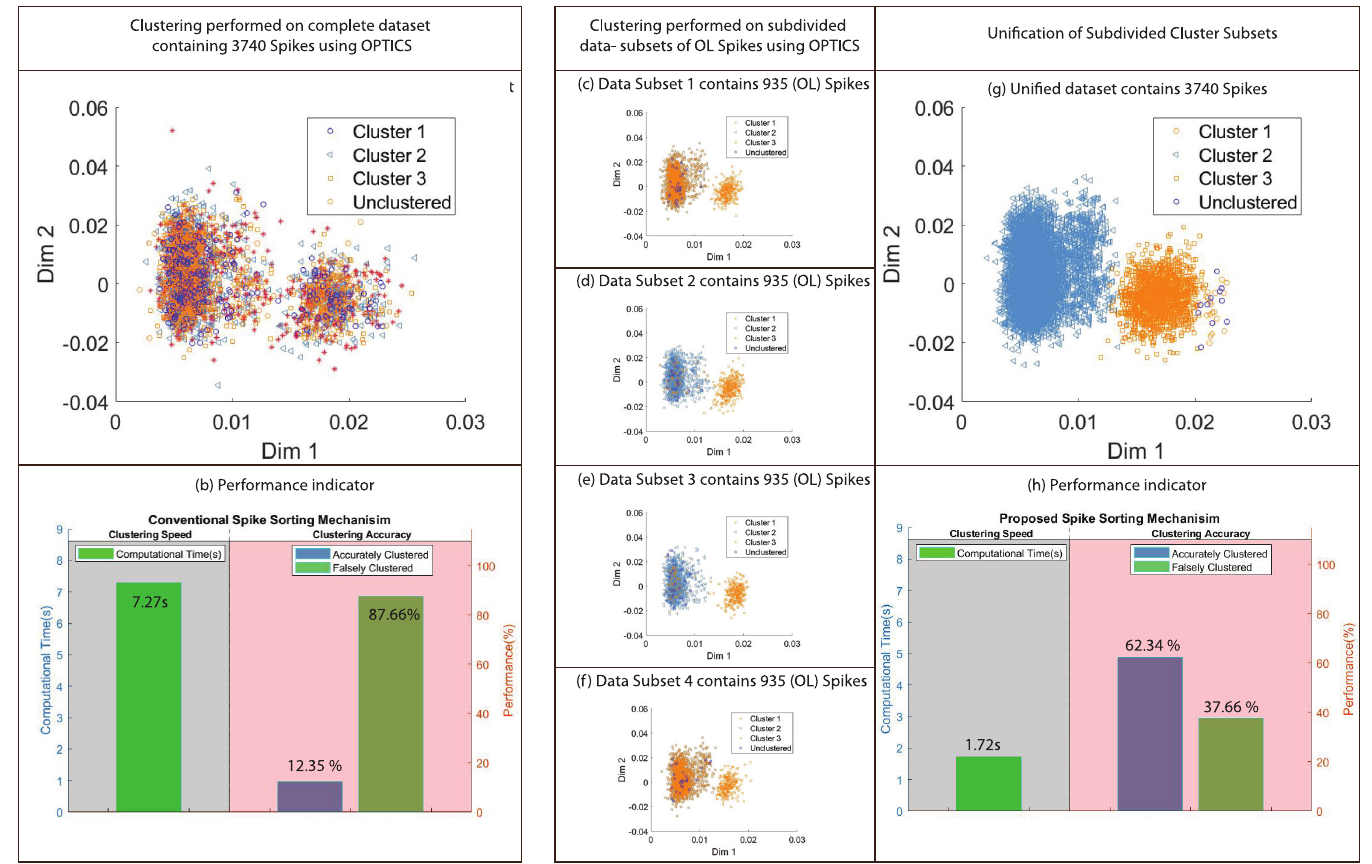
Fig 8. Comparison of clustering results obtained using conventional and proposed mechanism employing OPTICS with dataset 3 and PCA features. (a) Clustering results using conventional spike sorting method applied on complete dataset containing 3740 Spikes. (b) Performance indication of clustering results based on computational time/speed and clustering accuracy. (c)-(f) Clustering results using proposed spike sorting mechanism applied on data-subdivision of optimal length i.e 935 for OPTICS. (g) Unification of subdivided cluster subsets. (h) Performance indication of clustering results using proposed spike sorting method.